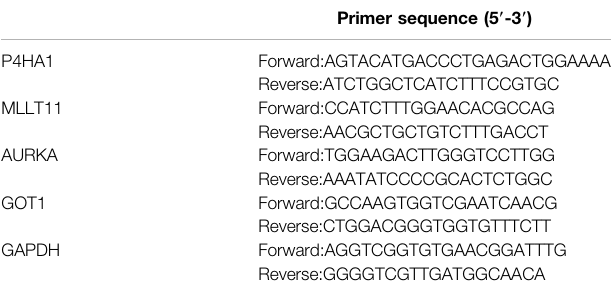
TABLE 1 | Primer sequences of P4HA1, MLLT11, AURKA, GOT1, and GAPDH.